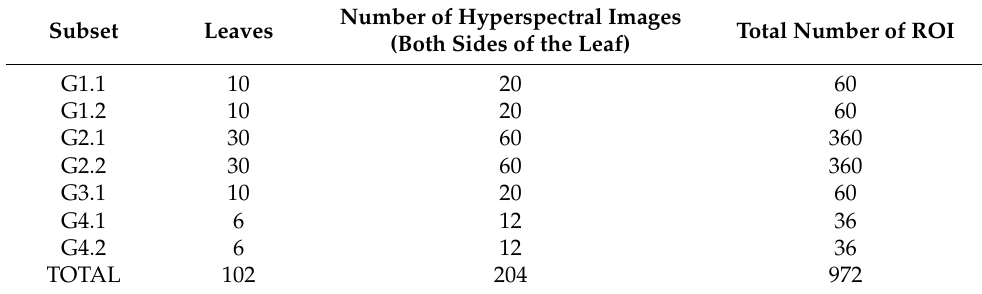
Table 2. Classification of the tagged database for